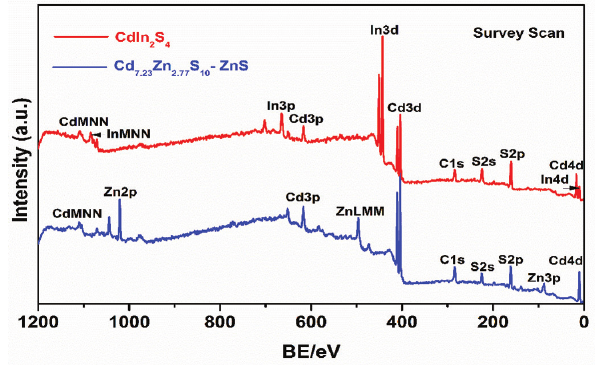
Figure 3: XPS survey scan spectra of CIS (red) and CZS-ZS (blue) thin